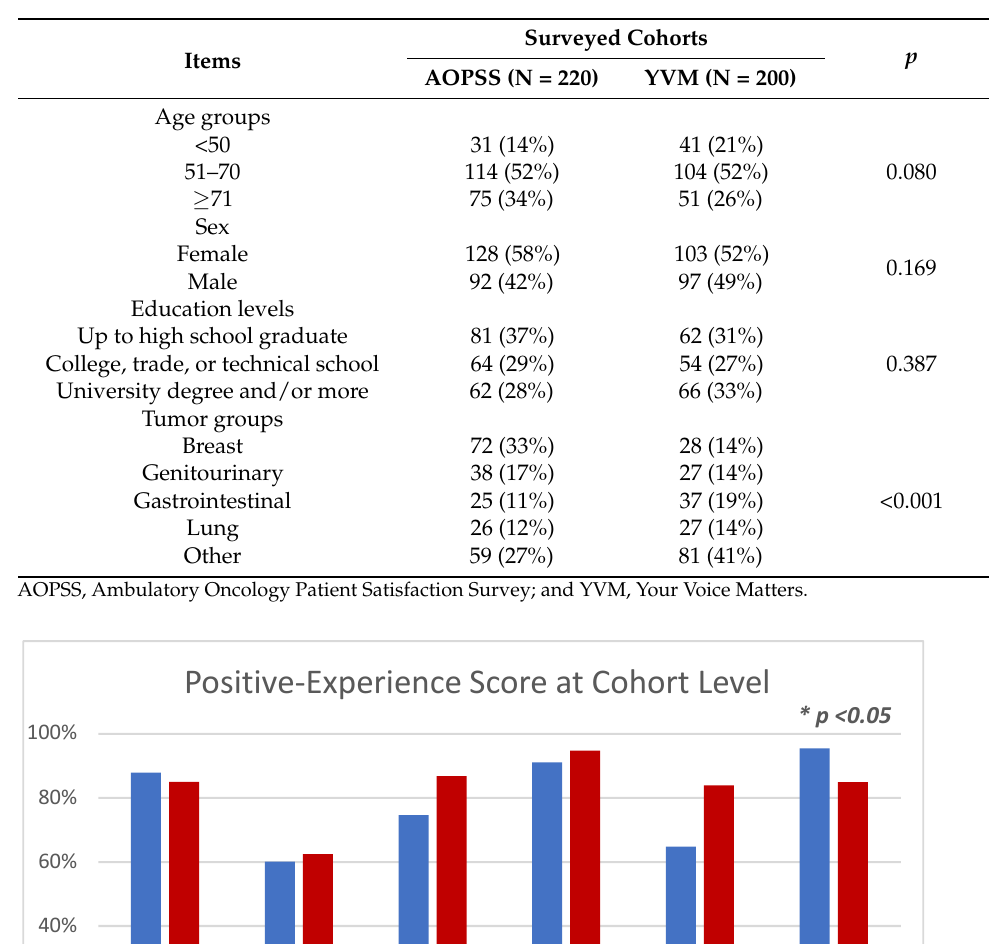
Table 3. Participant Characteristics.